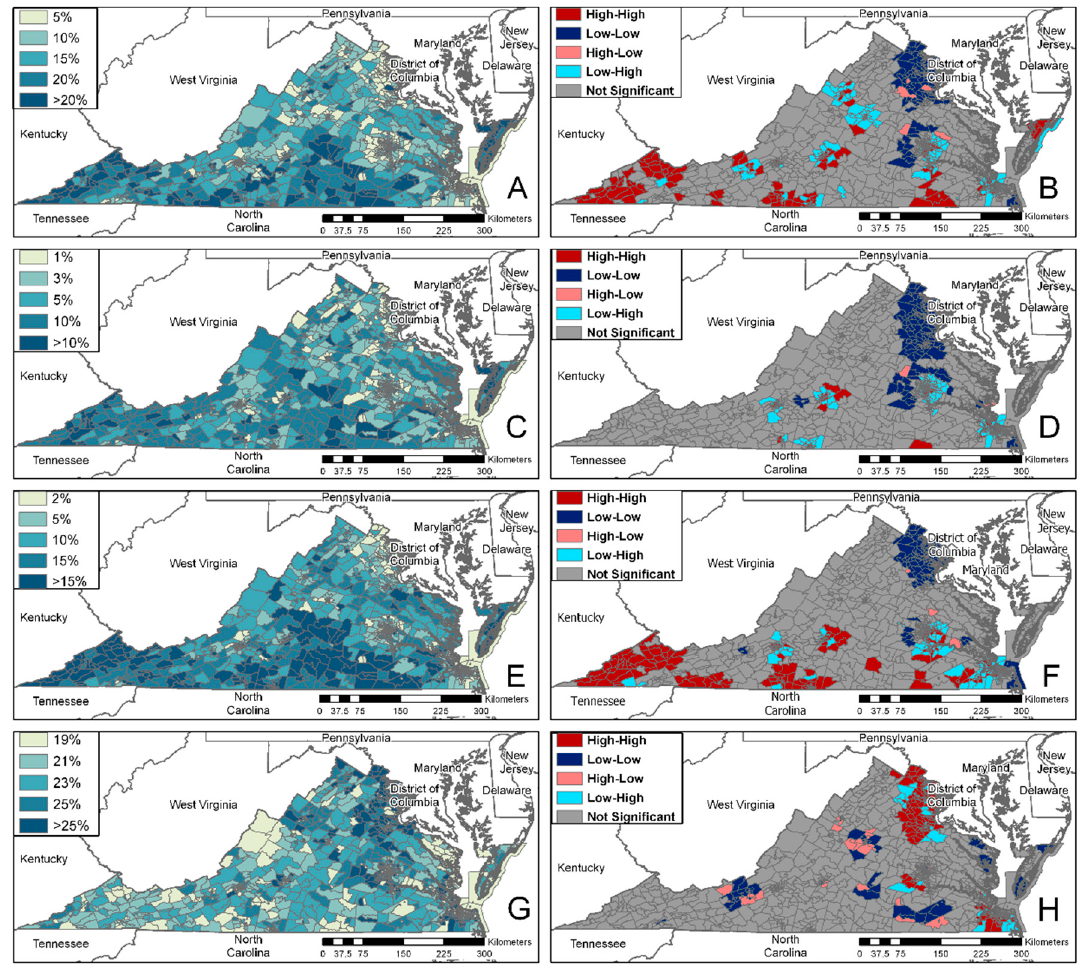
Figure 5. Poverty related risk factors by census tract: ( A ) Distribution of poverty rates; ( B ) Cluster analysis of poverty rates; ( C ) Distribution of rate of households without access to a vehicle; ( D ) Cluster analysis of rate of households without access to a vehicle; ( E ) Distribution of rate of households receiving SNAP benefits; ( F ) Cluster analysis of rate of households receiving SNAP benefits; ( G ) Percent of population below age 19; and ( H ) Cluster analysis of percent of population below age 19.